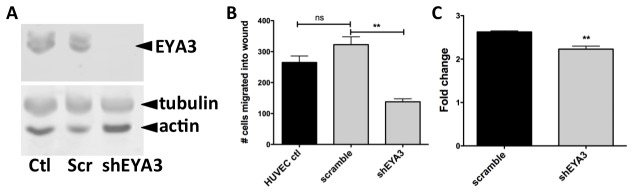
Effect of EYA3 knock-down on the migration and proliferation of HUVECs.(A) Western blot showing knockdown of EYA3 in HUVECs by infection with shEYA3 lentivirus relative to scramble (scr) non-specific RNA and control HUVEC cells. (B) EYA3 knock-down leads to a significant reduction in cell migration in a scratch wound healing assay. (C) EYA3 knock-down in HUVECs attenuates cell proliferation 72 hours post-seeding.